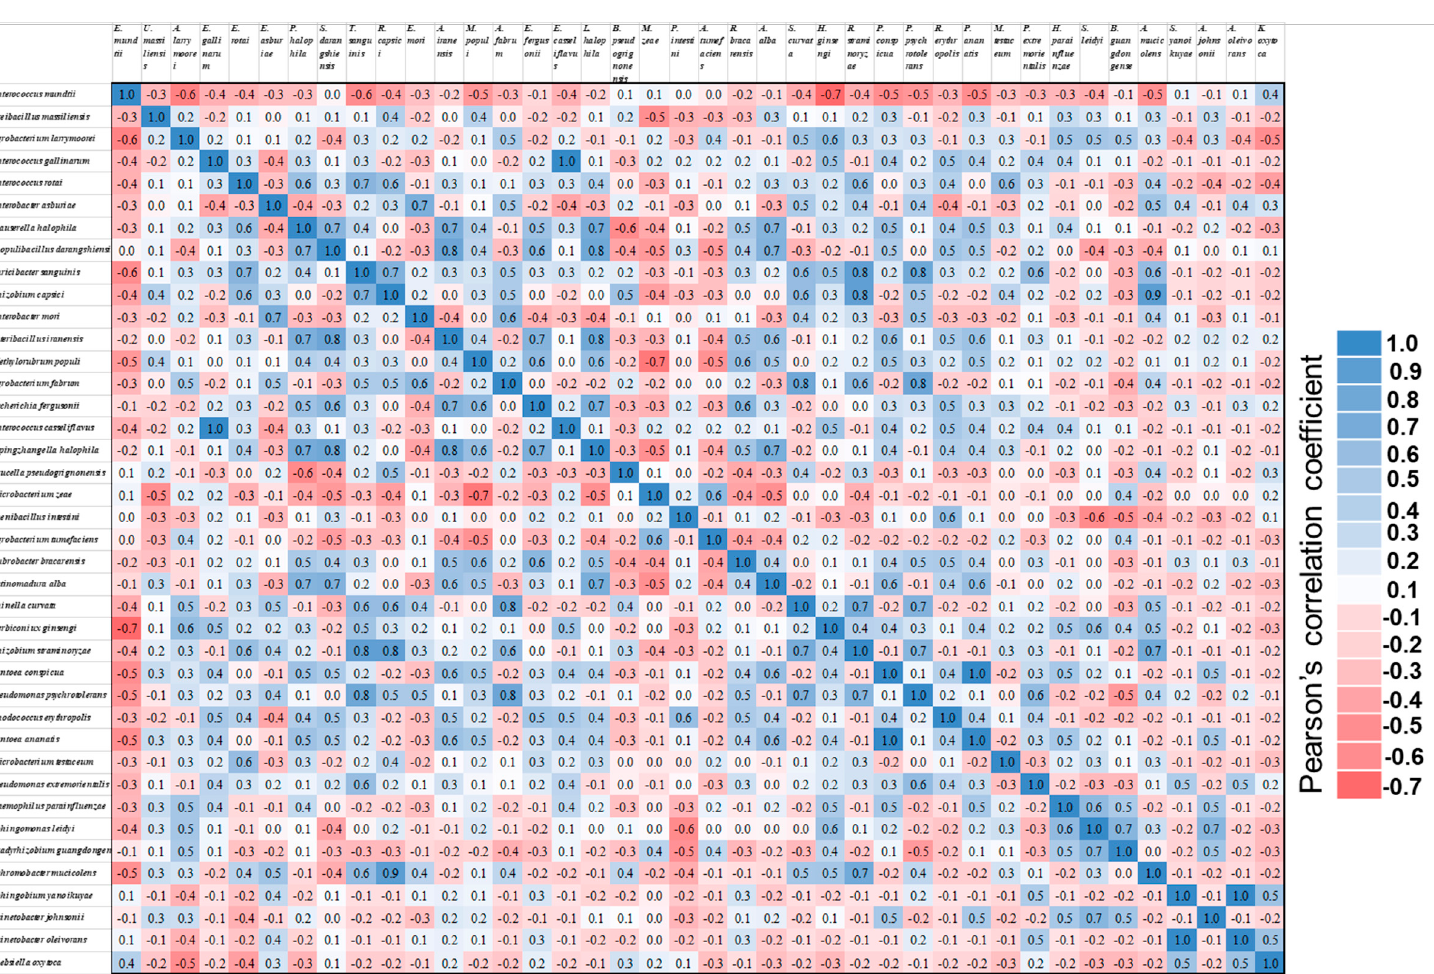
Figure 3. Spearman correlation coefficient quantifying the relationship of linear association between bacterial populations. Results took on a value between − 1 and +1, where − 1 indicates a perfect negative linear correlation and +1 a perfect positive linear correlation. The value ranged from ( − 3 to − 5) medium, ( − 5 to − 7) strong negative correlation (red color), and the opposite applied to the positive linear correlation (blue color). Enterococcus mundtii was the most prevalent bacterial species among the top 40 probable bacterial species. Additional information is exhibited in the Supplementary Figure S4.